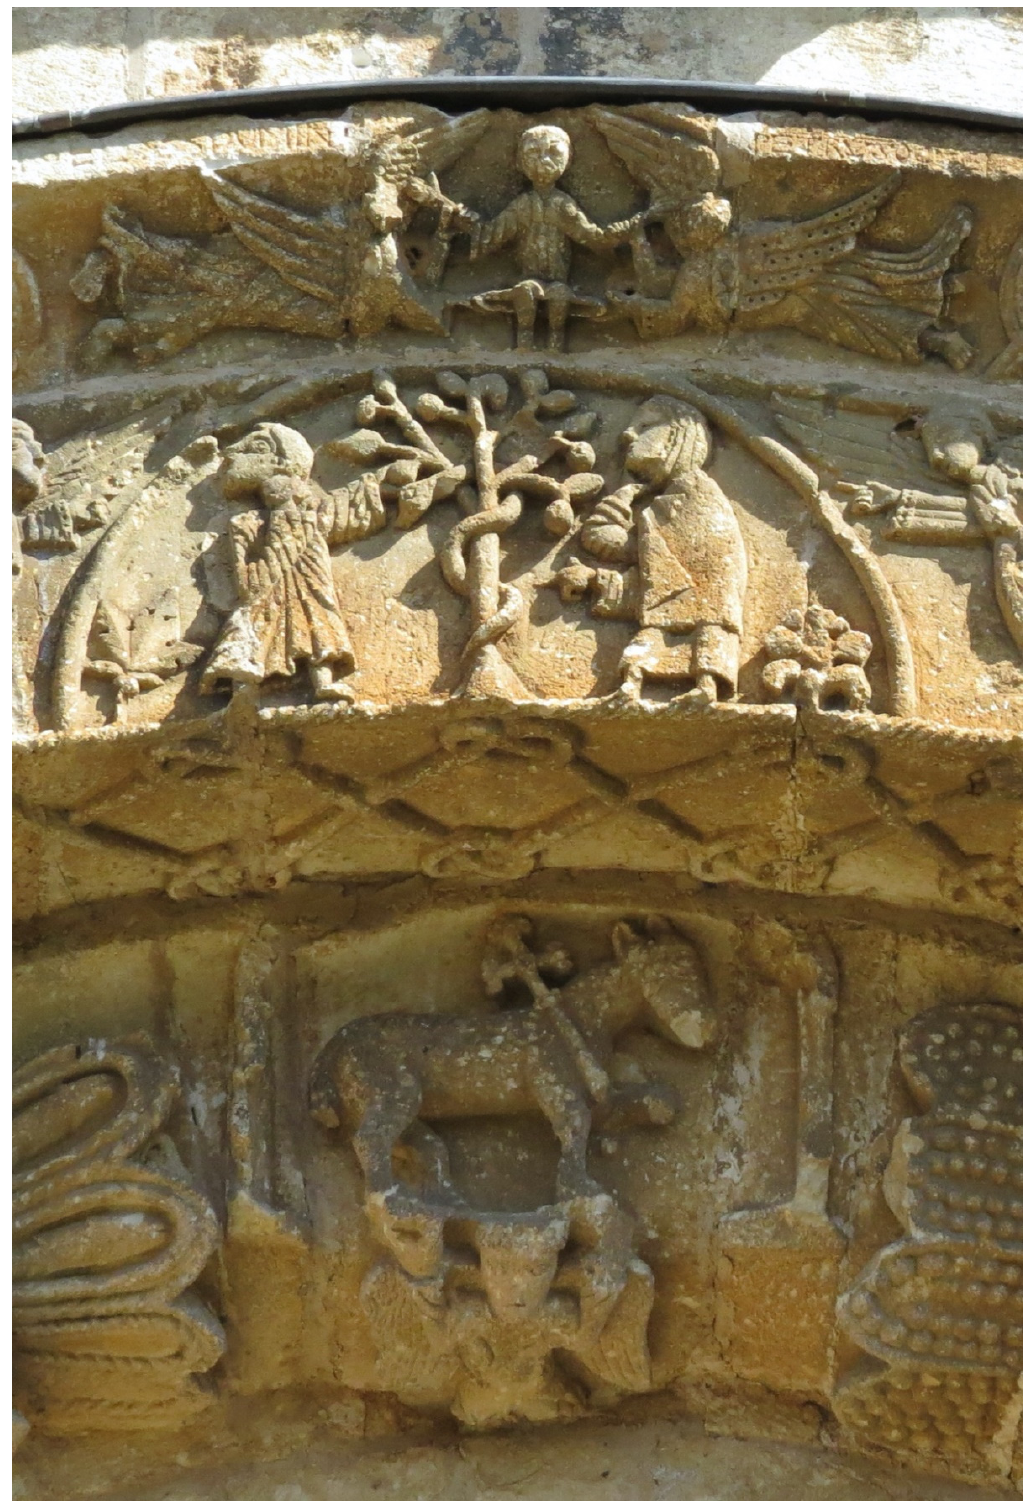
Figure 11. Apotheosis, Adam and Eve, and Agnus Dei, detail of archivolt, west façade, Saint-Martin Church , 12th c., Besse, Dordogne, Nouvelle-Aquitaine, France. ©Author.